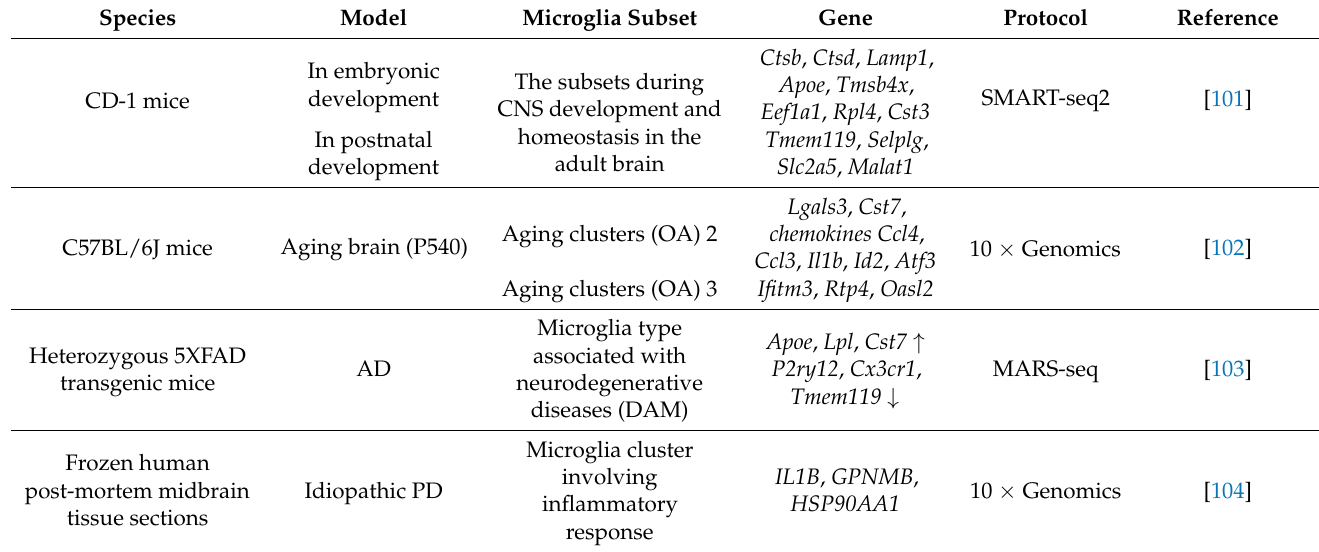
Table 2. Single-cell profiles of specific microglia subsets at different developmental stages and pathological states. Ctsb , cathepsin B; Ctsd , cathepsin D; Lamp1 , lysosomal associated membrane protein 1; Apoe , apolipoprotein E; Tmsb4x , thymosin beta 4 X-linked; Eef1a1 , eukaryotic translation elongation factor 1 alpha 1; Rpl4 , ribosomal protein L4; Cst3 , cystatin 3; Tmem119 , transmembrane protein 119; Selplg , selectin P ligand; Slc2a5 , solute carrier family 2 member 5; Malat1 , metastasis associated lung adenocarcinoma transcript 1; Lgals3 , galectin-3; Cst7 , cystatin F; Ccl4 , C-C motif chemokine ligand 4; Ccl3 , C-C motif chemokine ligand 3; Il1b , interleukin 1 beta; Id2 , inhibitor of DNA binding 2; Atf3 , activating transcription factor 3; Ifitm3 , interferon induced transmembrane protein 3; Rtp4 , receptor transporter protein 4; Oasl2 , 2 (cid:48) –5 (cid:48) oligoadenylate synthetase-like 2; Lpl , lipoprotein lipase; P2ry12 , purinergic receptor P2Y12; Cx3cr1 , C-X3-C motif chemokine receptor